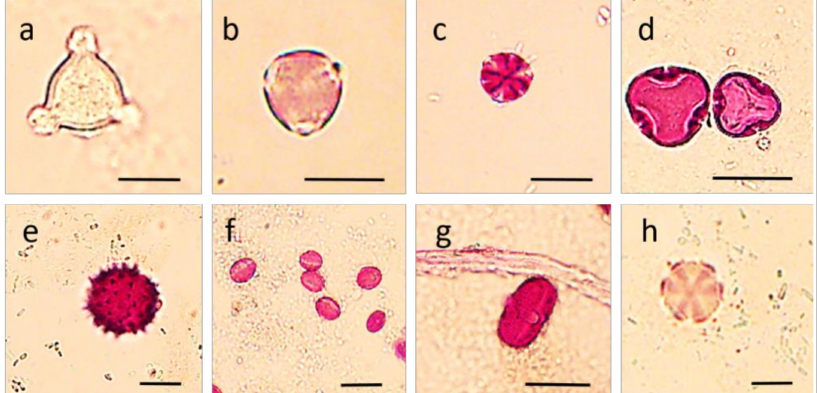
Figure 1. Characteristic pollen grains observed in the honey samples. ( a ) Acacia— Robinia pseudoa- cacia , ( b ) Amorpha— Amorpha fruticosa , ( c ) Phacelia— Phacelia tanacetifolia , ( d ) Linden— Tilia spp., ( e ) Sunflower— Helianthus annuus , ( f ) Chestnut— Castanea sativa , ( g ) Fennel ( Foeniculus vulgaris )— Apiaceae pollen, ( h ) Meadow sage ( Salvia pratensis )—Lamiaceae pollen. Scale bar = 25 µ